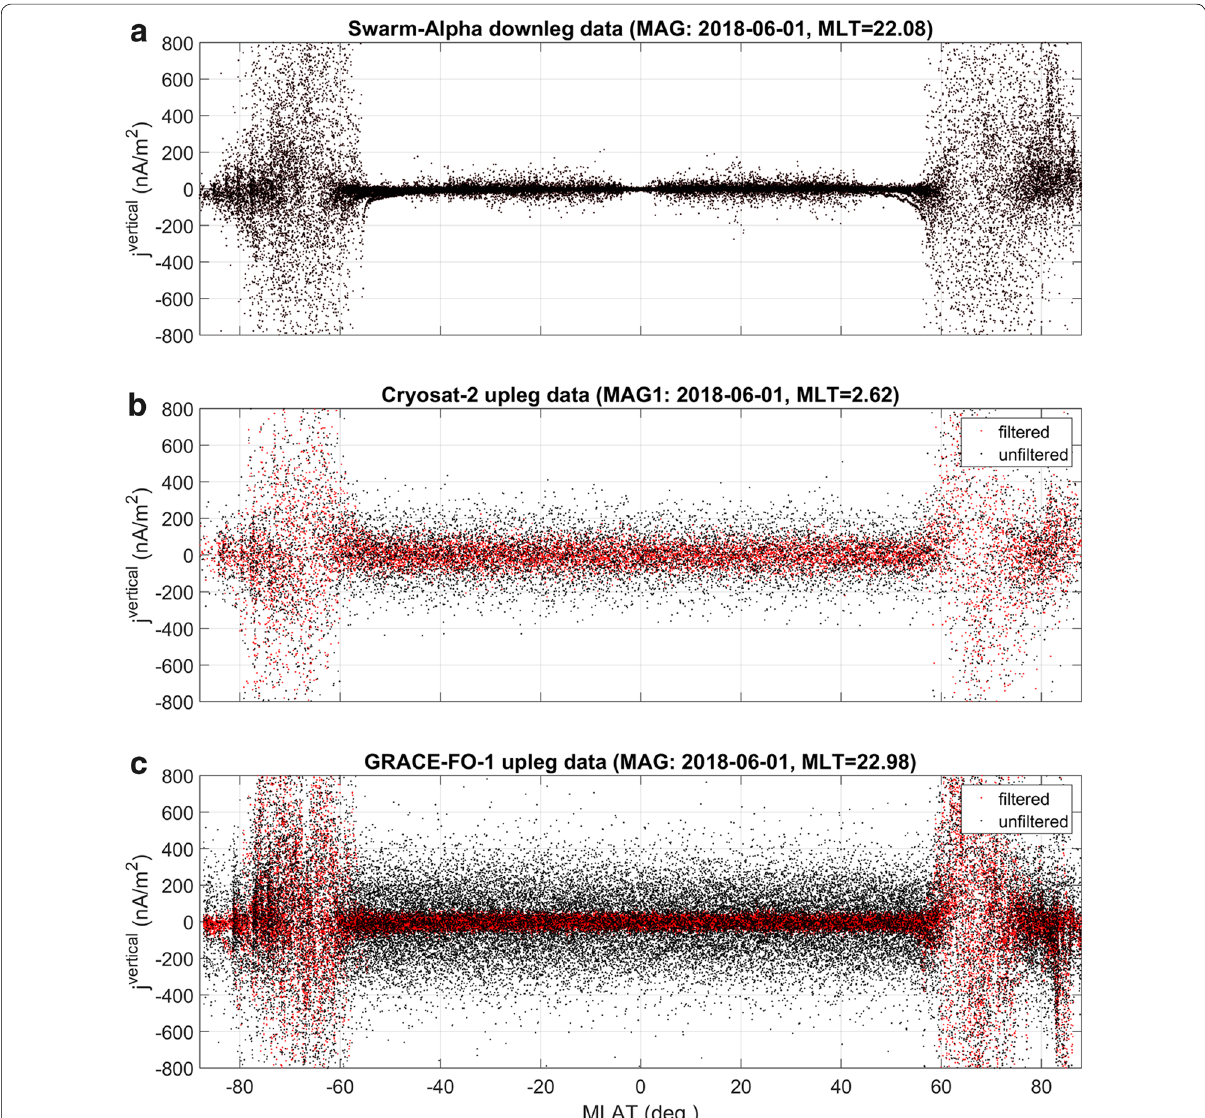
Fig. 12 Scatterplots of unfiltered (black) and filtered (red) vertical current density of a Swarm, b CryoSat-2, and c GRACE-FO for an example day of 01 June